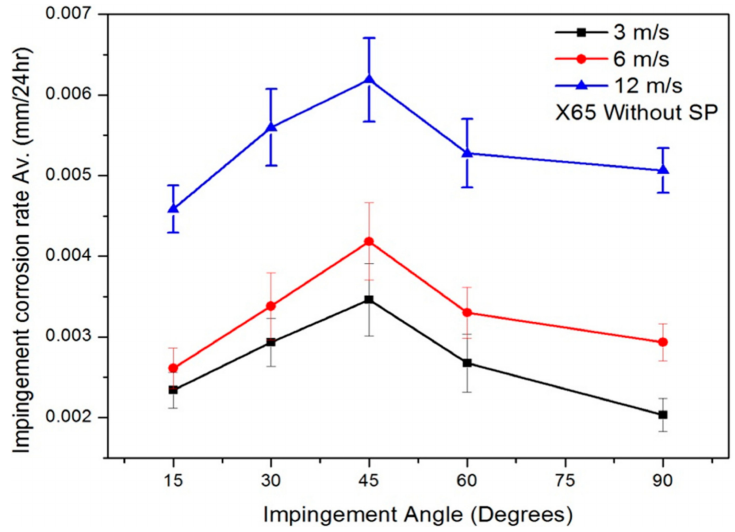
Figure 3. Effect of impingement velocity and angle on the corrosion rate (without solid particles) of API 5L-X65